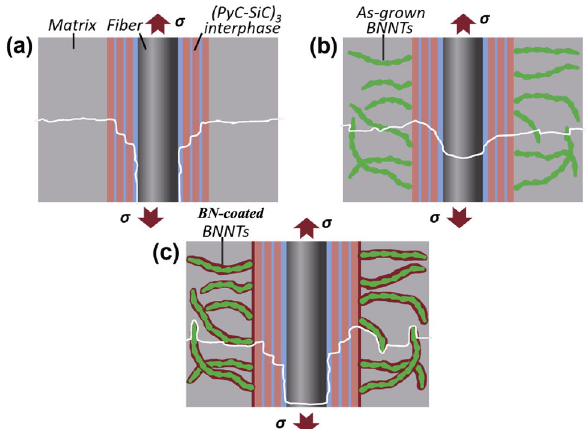
Fig. 7 Schematic presentation of crack propagations in (a) virgin SiC f /SiC composites, (b) as-grown, and (c) BN-coated BNNTs reinforced SiC f /SiC hierarchical